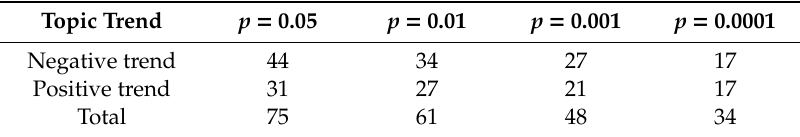
Table 2. Topics with significant negative and positive trends at four significant levels. Topic Trend p =